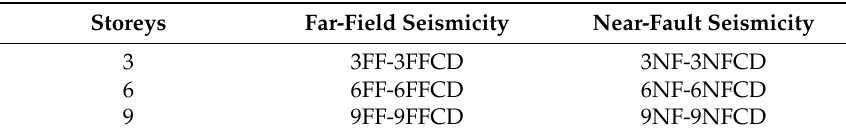
Table 1. Summary of buildings